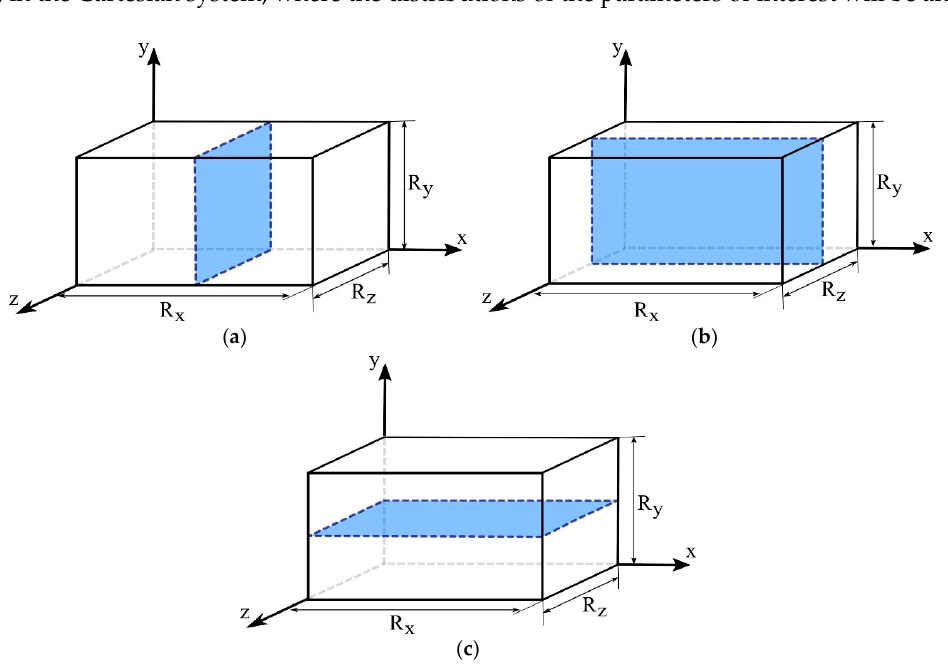
Figure 13. Kinetics of the average entrapped solute concentration fort different distances l x (Cases 8, 9, and 10). Figure 14. Kinetics of the average moisture content for different distances l x (Cases 8, 9, and 10).